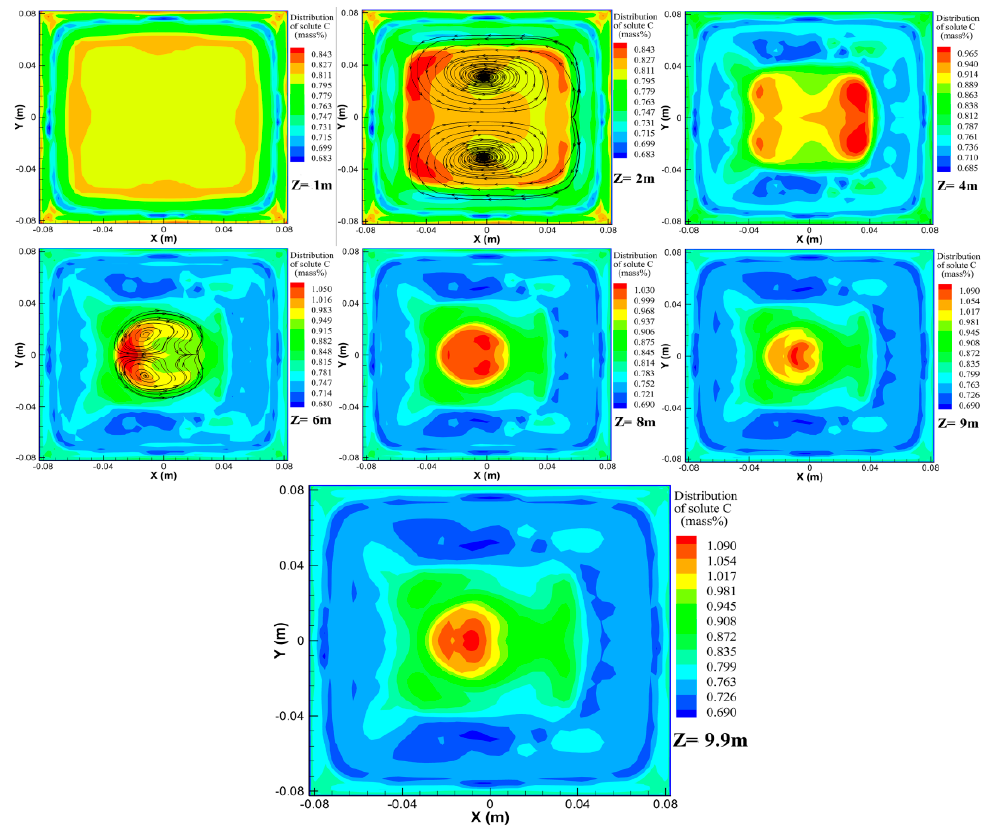
Figure 13. Computed distribution of solute C at different billet cross sections.